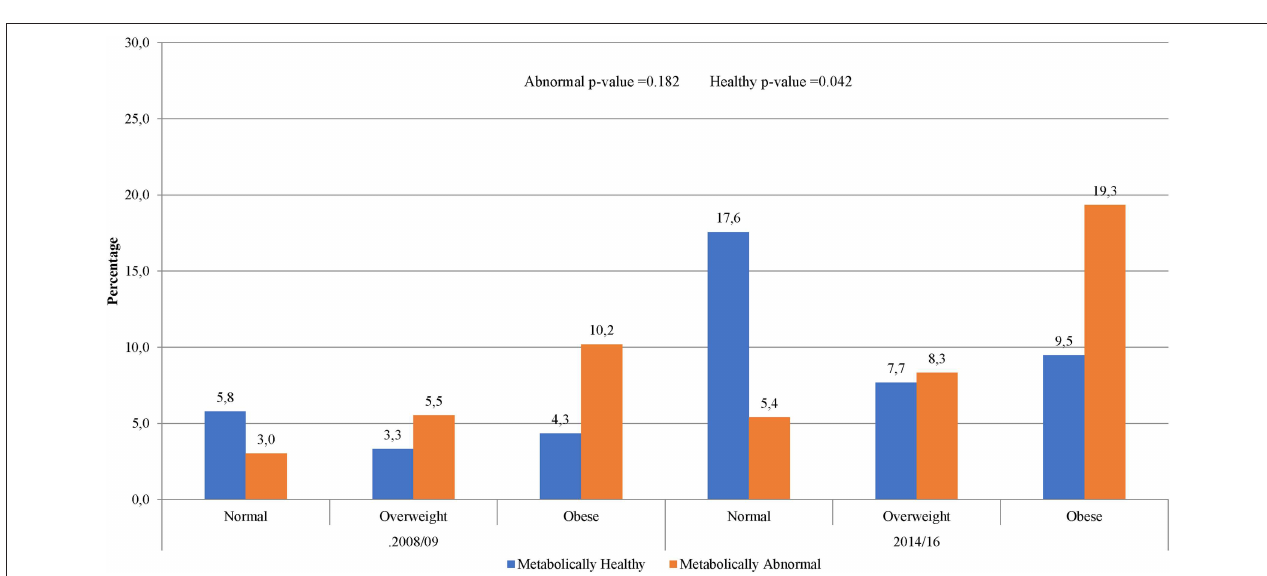
The Metabolic Profile Within and Across BMI Categories Within BMI categories, metabolically abnormal participants compared with their metabolically healthy counterparts, were older (normal weight: 56.0 vs. 44.1 years; overweight: 56.0